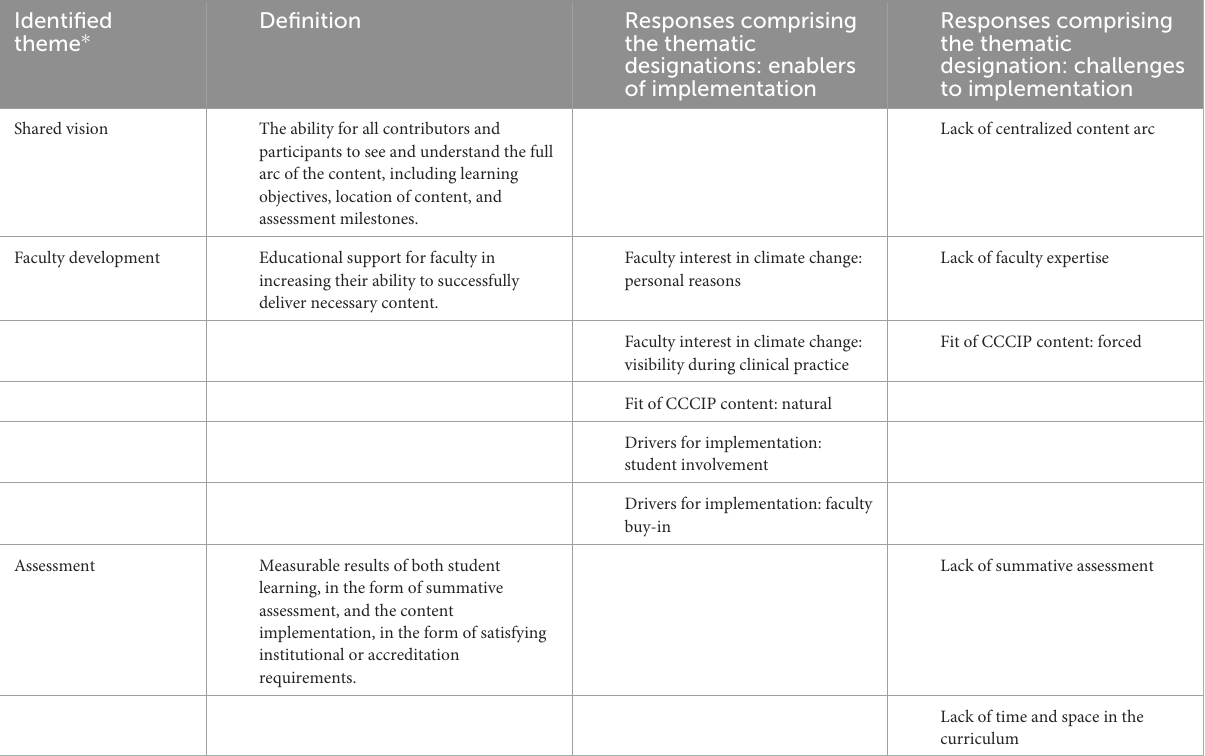
TABLE 3 Codebook from faculty interviews with lecturers and course